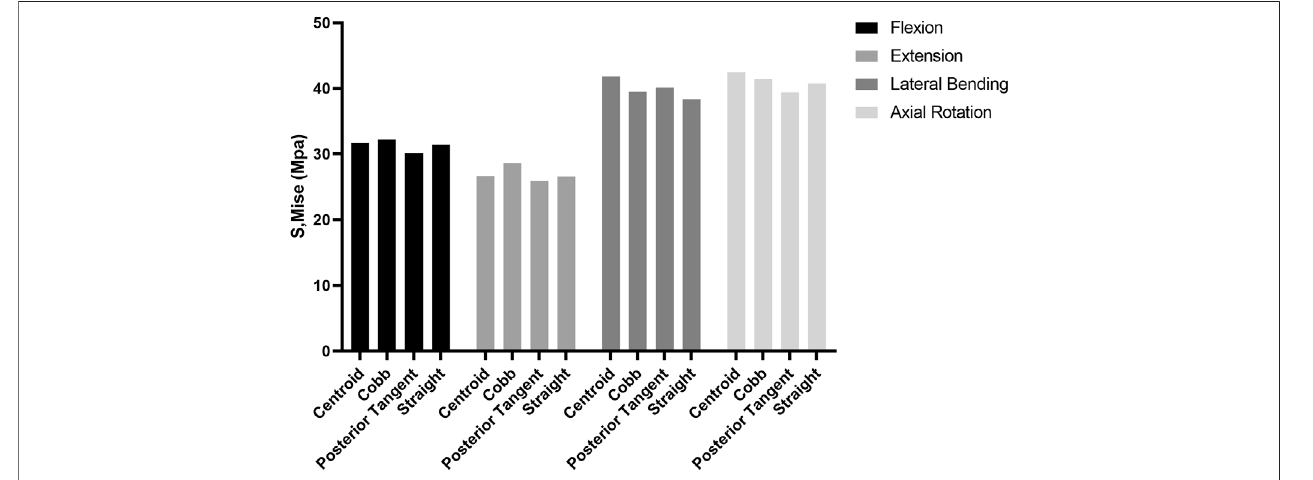
FIGURE 6 | Comparison of maximum stress in fi xation (MSF) for four RC models in fl exion, extension, lateral bending, and axial rotation.